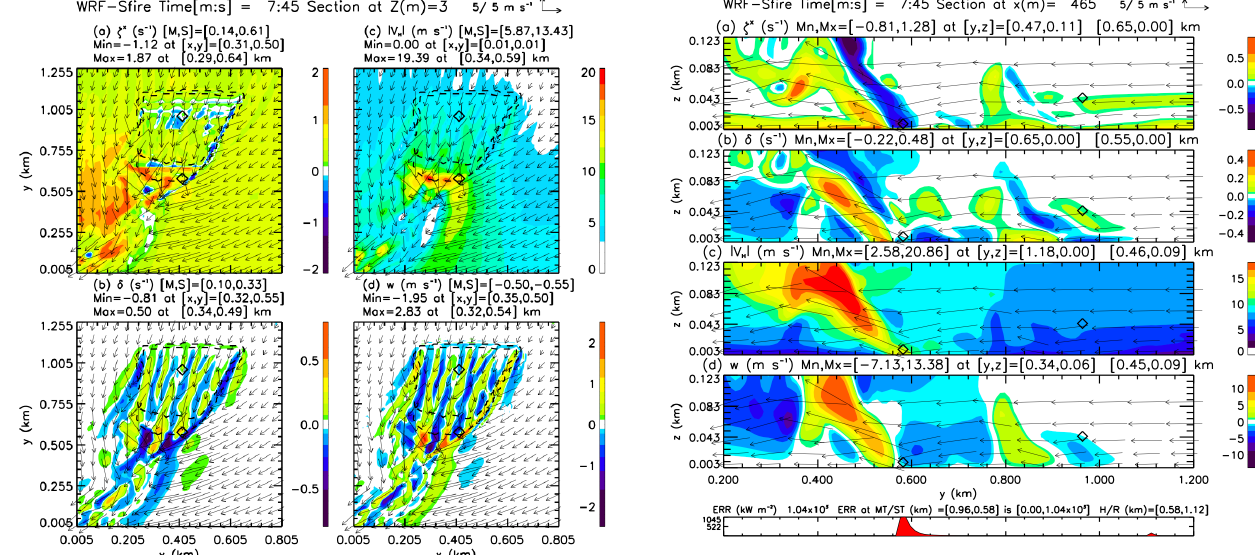
Fig. 14. As in Fig. 10 except for 7:45 [min:s] into the WRF-SFIRE simulation.